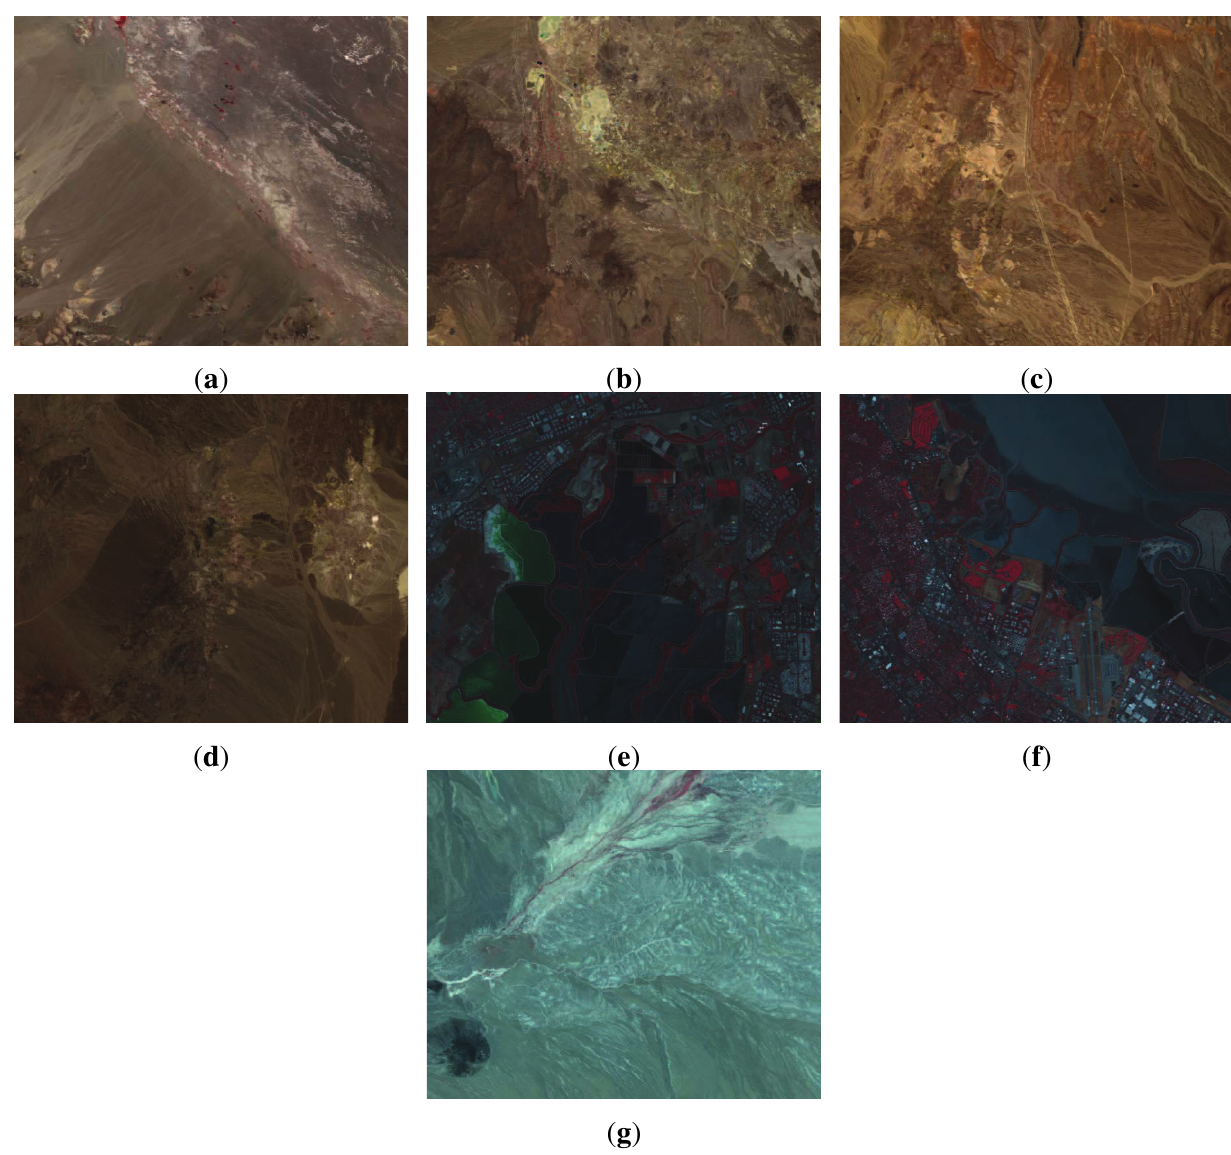
Figure 1. False-color composites of experimental hyperspectral images: ( a ) Lun.lake Cuprite ; ( c ) Cuprite ; ( d ) Cuprite ; ( e ) Moffet _ igm ; ( f ) Moffet 02 03 04 02 Lun.lake _ igm . Table 1. Variances and ranges of pairwise distances for different subgroups of seven hyperspectral